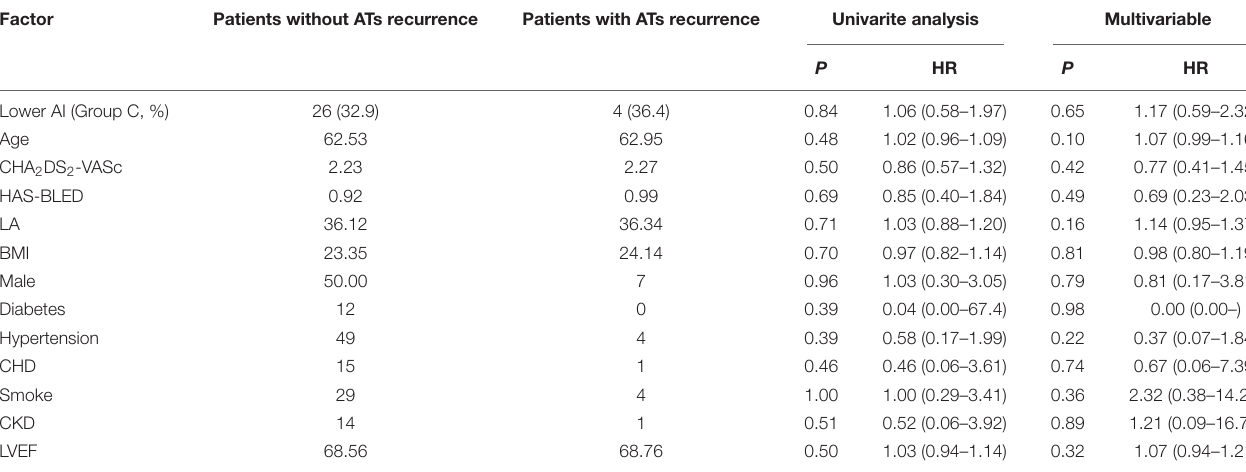
TABLE 4 | Univariate and multivariate Cox regression analysis for ATa recurrence. Factor